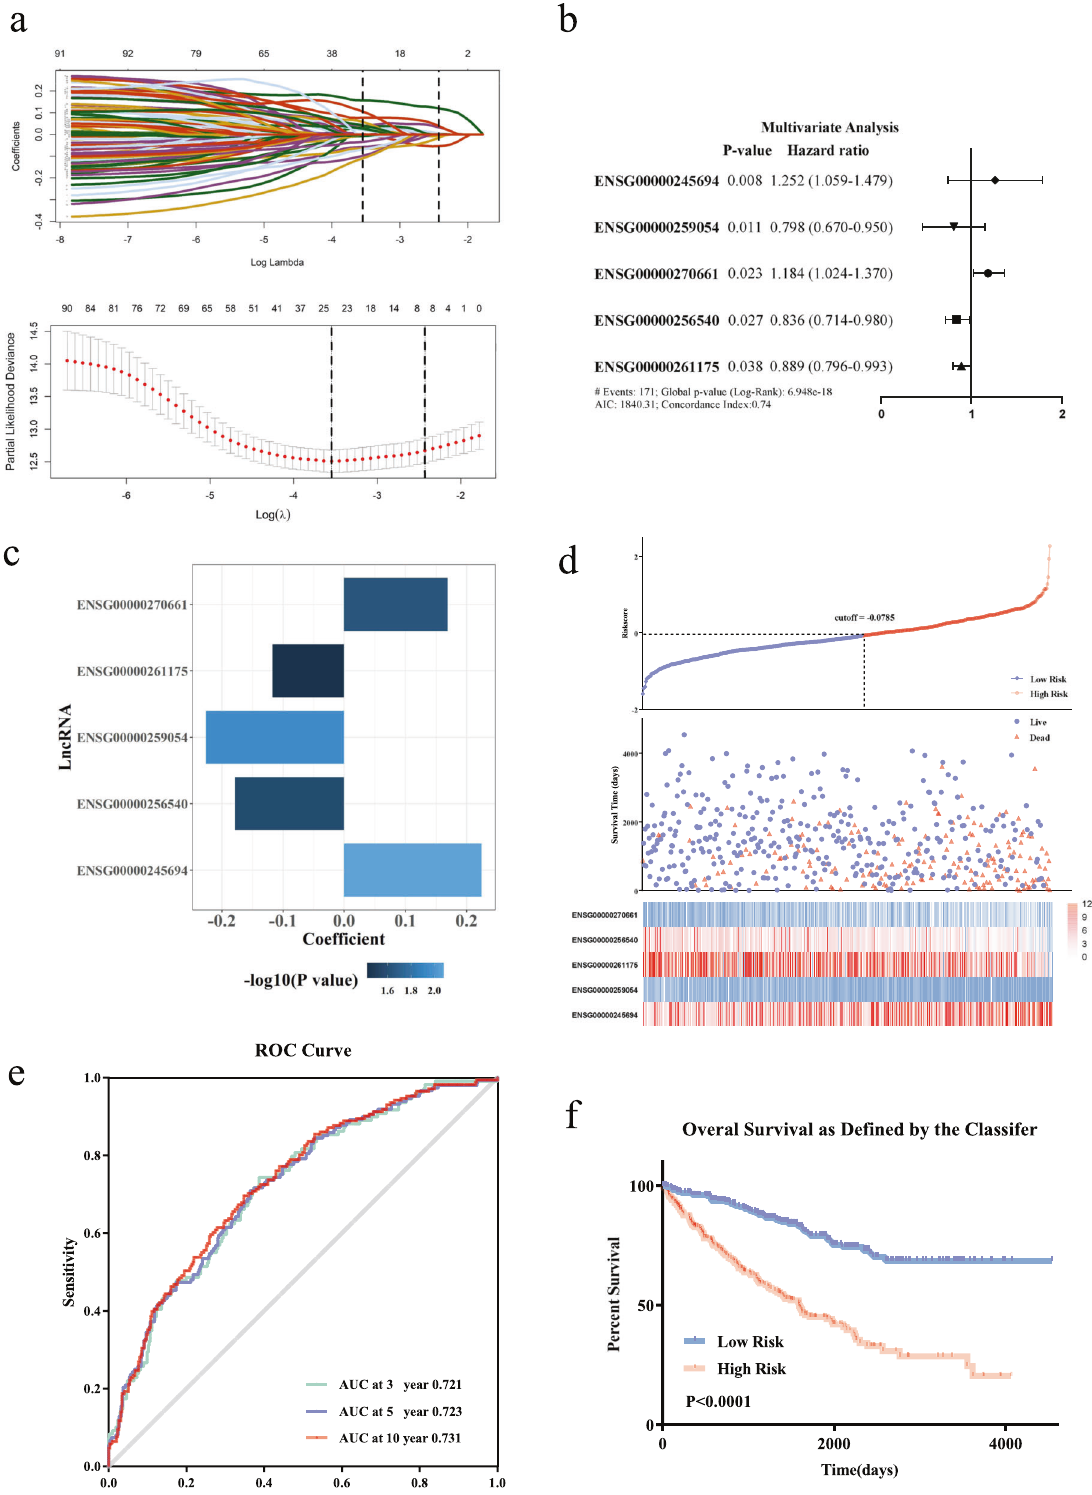
Fig. 2 The lncRNA prognostic model. a Lasso regression analysis of 94 DElncRNAs. Those with P < 0.05 were showed. b A forest plot illustrating the HR and P -value from the multivariate cox regression analysis of 24 DElncRNAs. Those with P < 0.05 were showed. c The bar plot shows coef fi cients of fi ve lncRNAs in the prognostic model. d Risk score system of the prognostic model. The above scatterplot exhibits the risk scores of each ccRCC patient with survival data. The middle scatterplot showed the relationship between the risk scores and the survival status/survival time. The below heatmap displays the expression pro fi les of the fi ve lncRNAs in the prognostic model. e The time-dependent ROC curve of OS suggests the reliability of the prognostic model. f Kaplan – Meier overall survival curves for ccRCC patients exhibited that the OS of high-risk group was shorter than the OS of low-risk